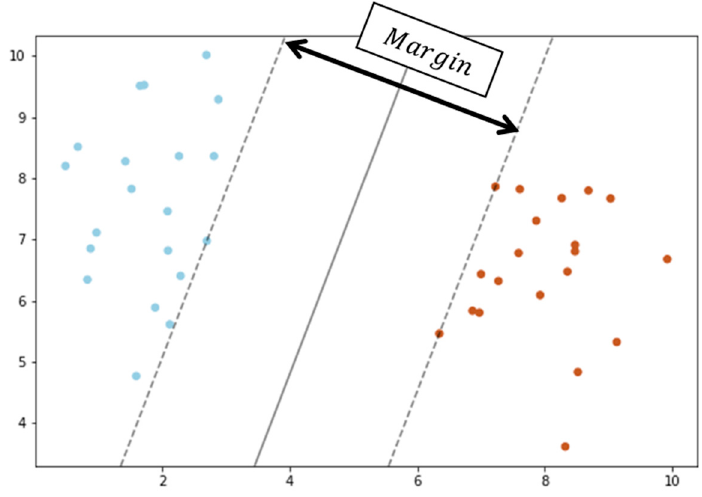
Figure 5. Basic example of an SVM process to set hyperplane with the maximum margin.